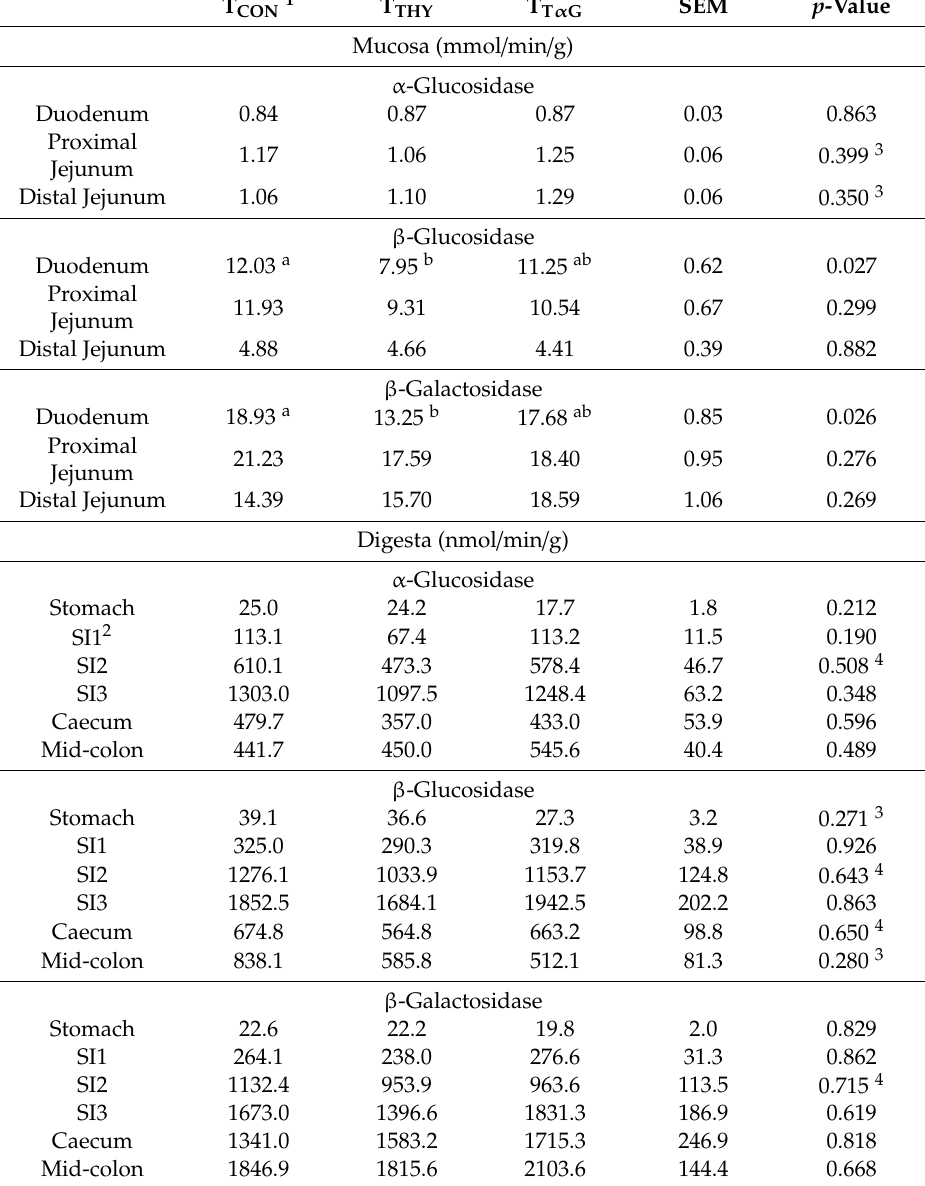
Table 6. The e ff ect of dietary treatment on the glycosidase activity in the mucosa (mmol / min / g) and digesta (nmol / min / g) of